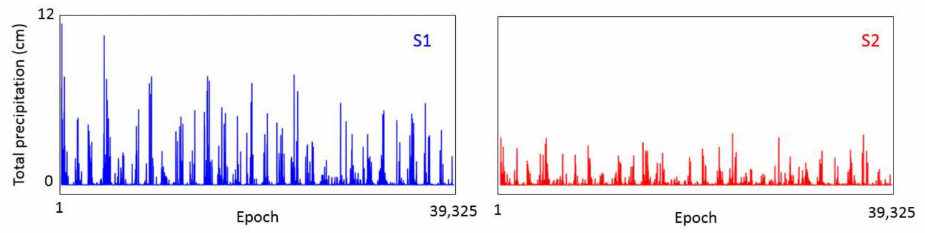
Figure 4. Quad-daily (six h) precipitation at the location of two selected stations S1 and S2 from January 1995 to December 2021, extracted from ERA5 data.